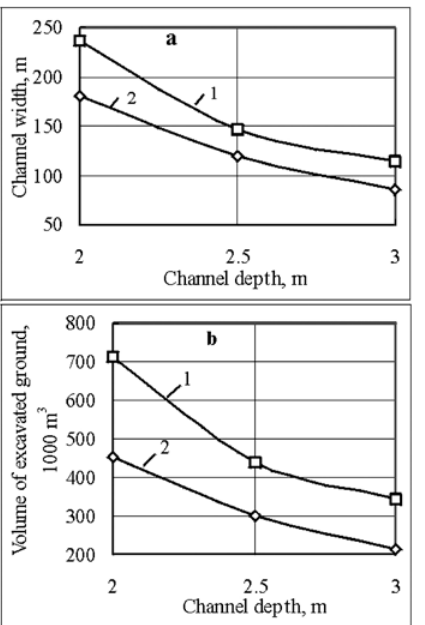
Fig. 9. Dependence of required channel width (graph a) and ground volumes for excavation from the channel (graph b) on channel depth, when the desired increase in sediment deposition in the valley, after building the channel, is: 1 – 70%, 2 – 50%